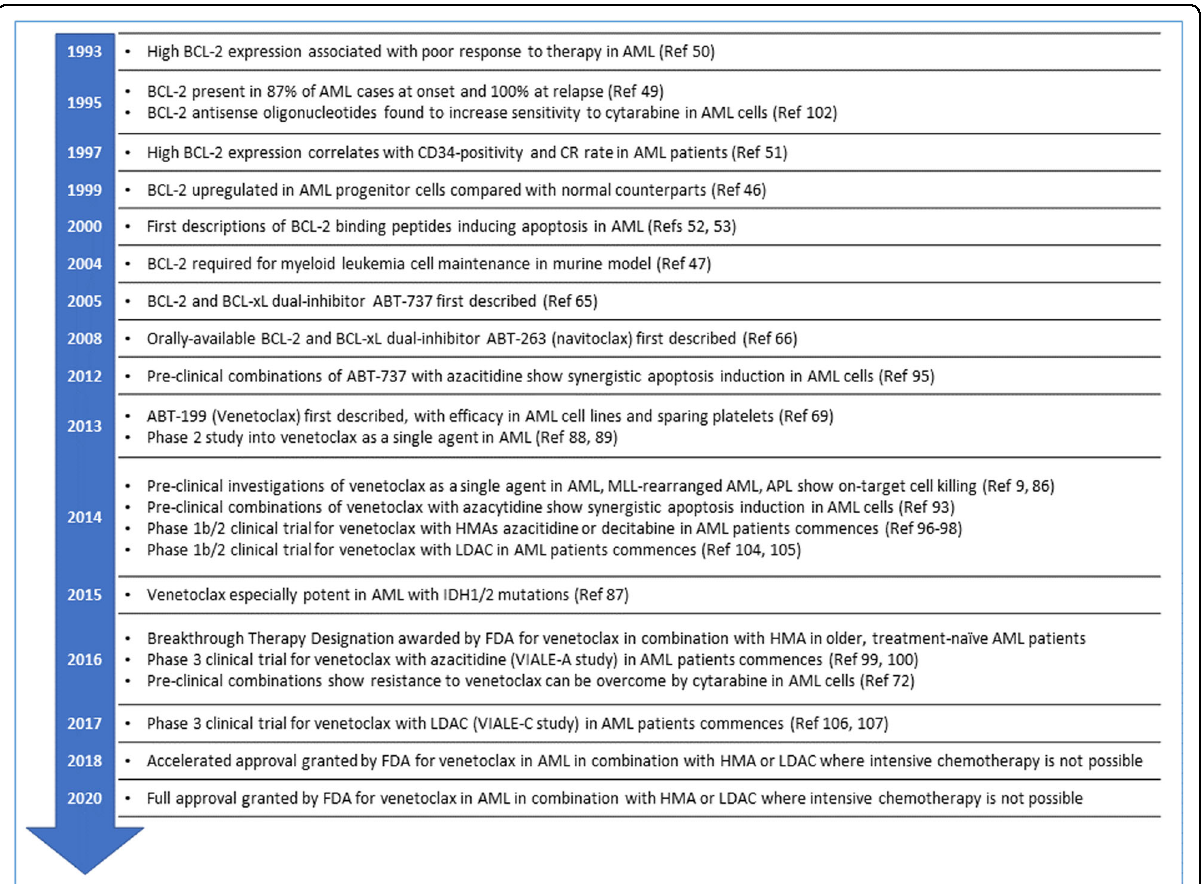
Fig. 5 The journey from development to clinical application of venetoclax is a triumph of rational cancer therapy design. Extensive experimental data identifying the prosurvival BCL-2 family members as potential therapeutic targets, focused preclinical work combining BH3 mimetics with standard-of-care therapies in AML, and highly promising, international clinical trials have led to FDA approval of venetoclax with HMA or LDAC in an impressively short